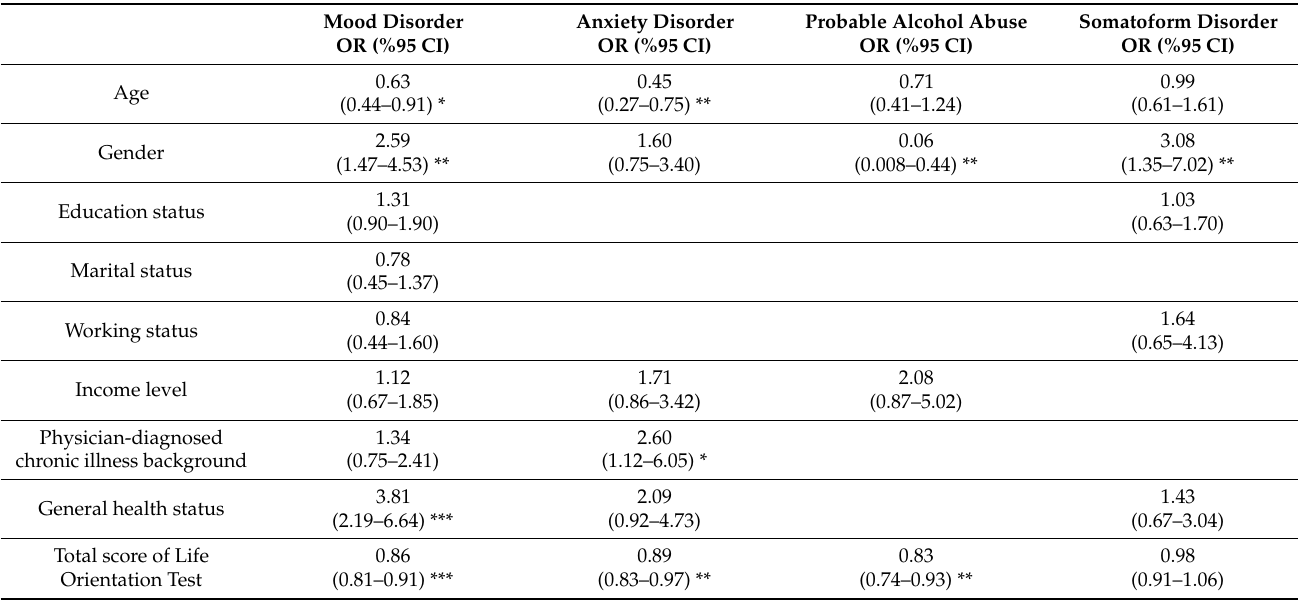
Table 3. The results of the multi-logistic regression model performed for determining the relationship between the mental disorder diagnoses obtained from PRIME MD and LOT scores, after adjusting for related factors in the study